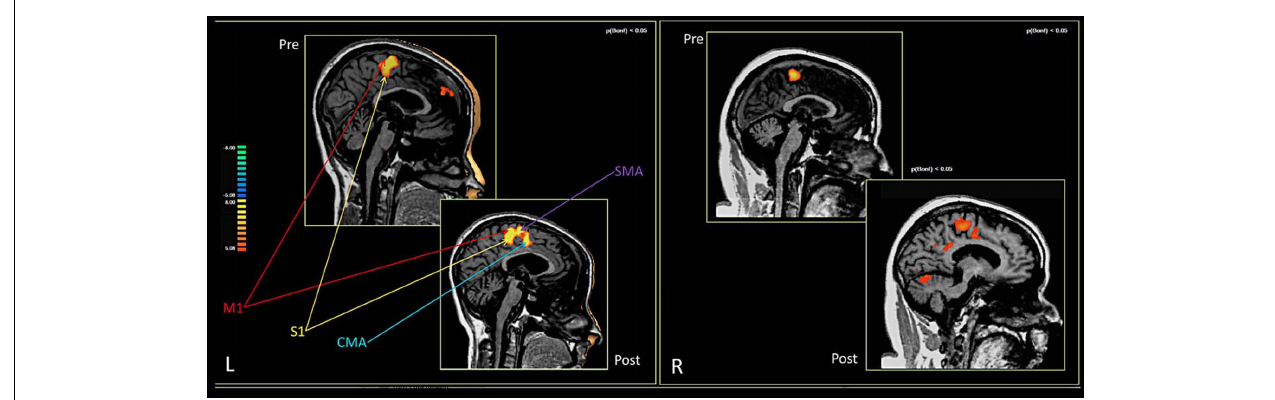
FIGURE 3 | Brain activations in the pre- and post-training conditions. Patient M.E. on the left. Patient S.R. on the right.